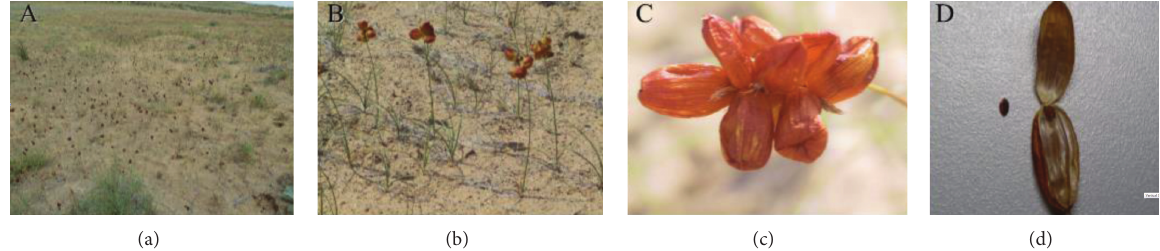
Figure 1: The habitat and morphology of Carex physodes in Gurbantunggut Desert. Habitat (a); ramet (b); infructescence (c); and fruit and seed (d).